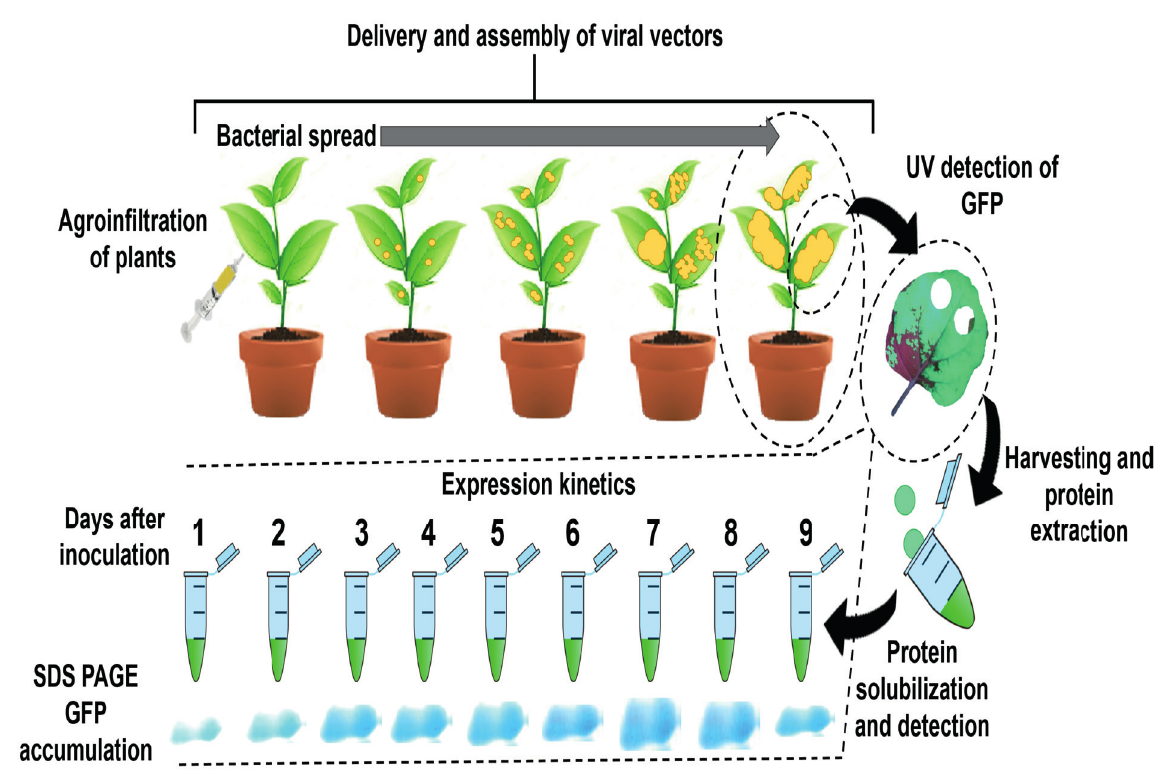
Figure 2 - expression kinetics of foreign genes in N. benthamiana leaves. The gene delivery strategy mediated by A. tumefaciens allows the effi cient spread of AMPs coding genes and integration to the host cells. Potent viral promoters induce high expression rates of the green Fluorescent Protein (gFP) from Aequorea victoria gene, a frequent reporter gene used for experimental validation. The peak of expression is about the seventh or eighth day after